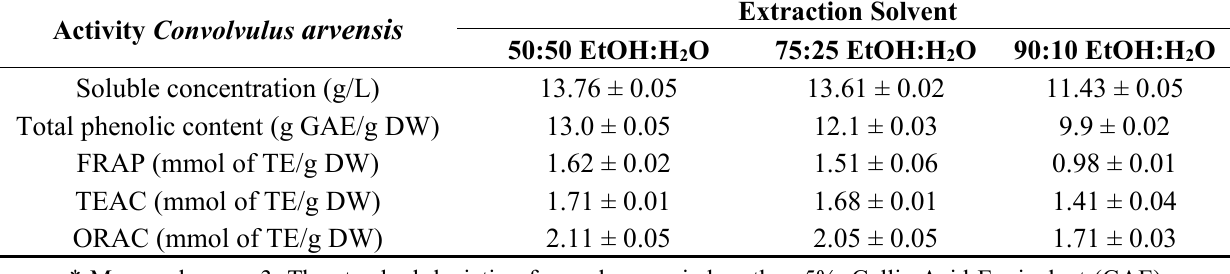
Table 1. Soluble solids concentration, total phenolic content (TPC) and antioxidant activity of Convolvulus arvensis Linn (CA)